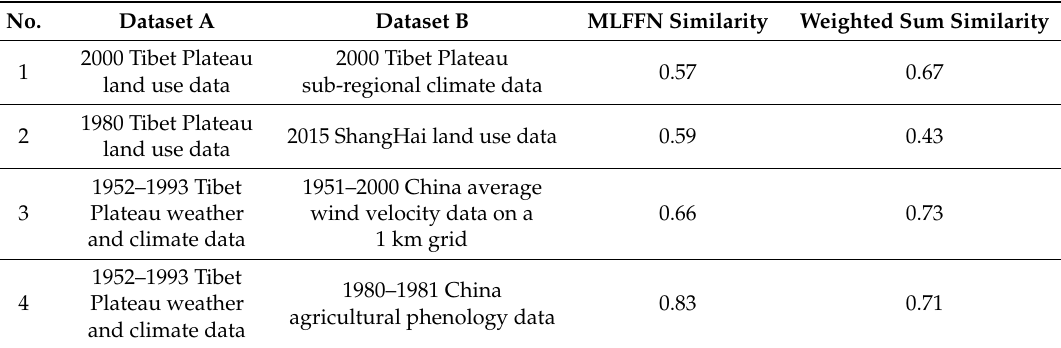
Table 11. The data pairs in different orders ranked by MLFFN and weighted sum